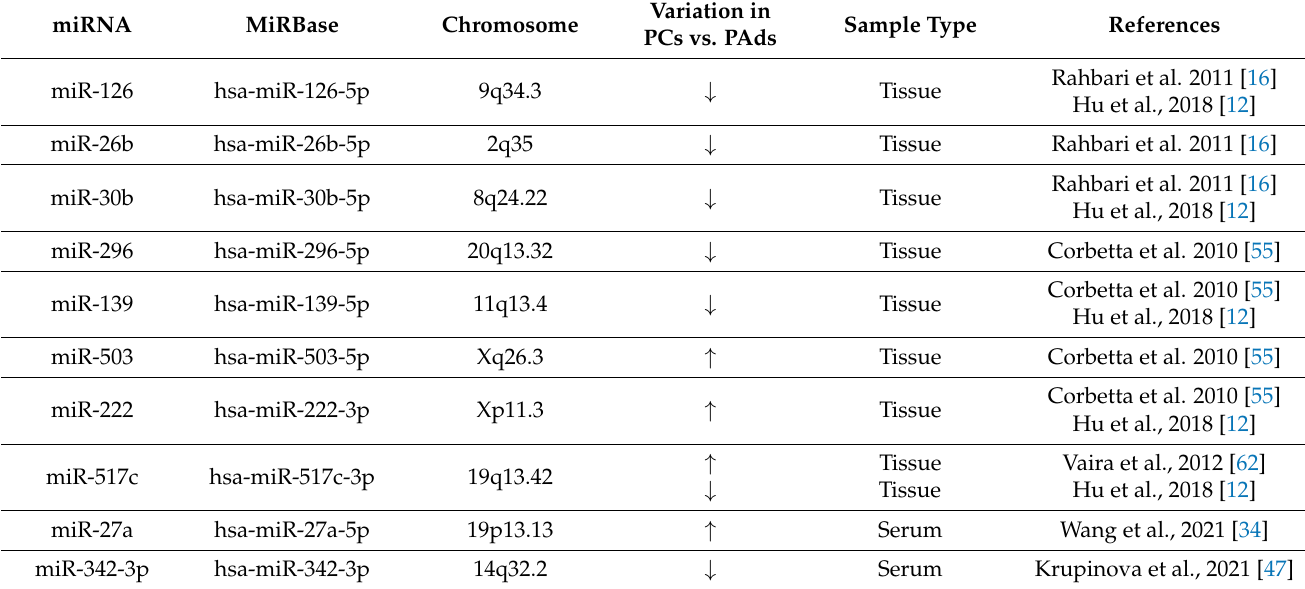
Table 2. Differentially expressed miRNAs in